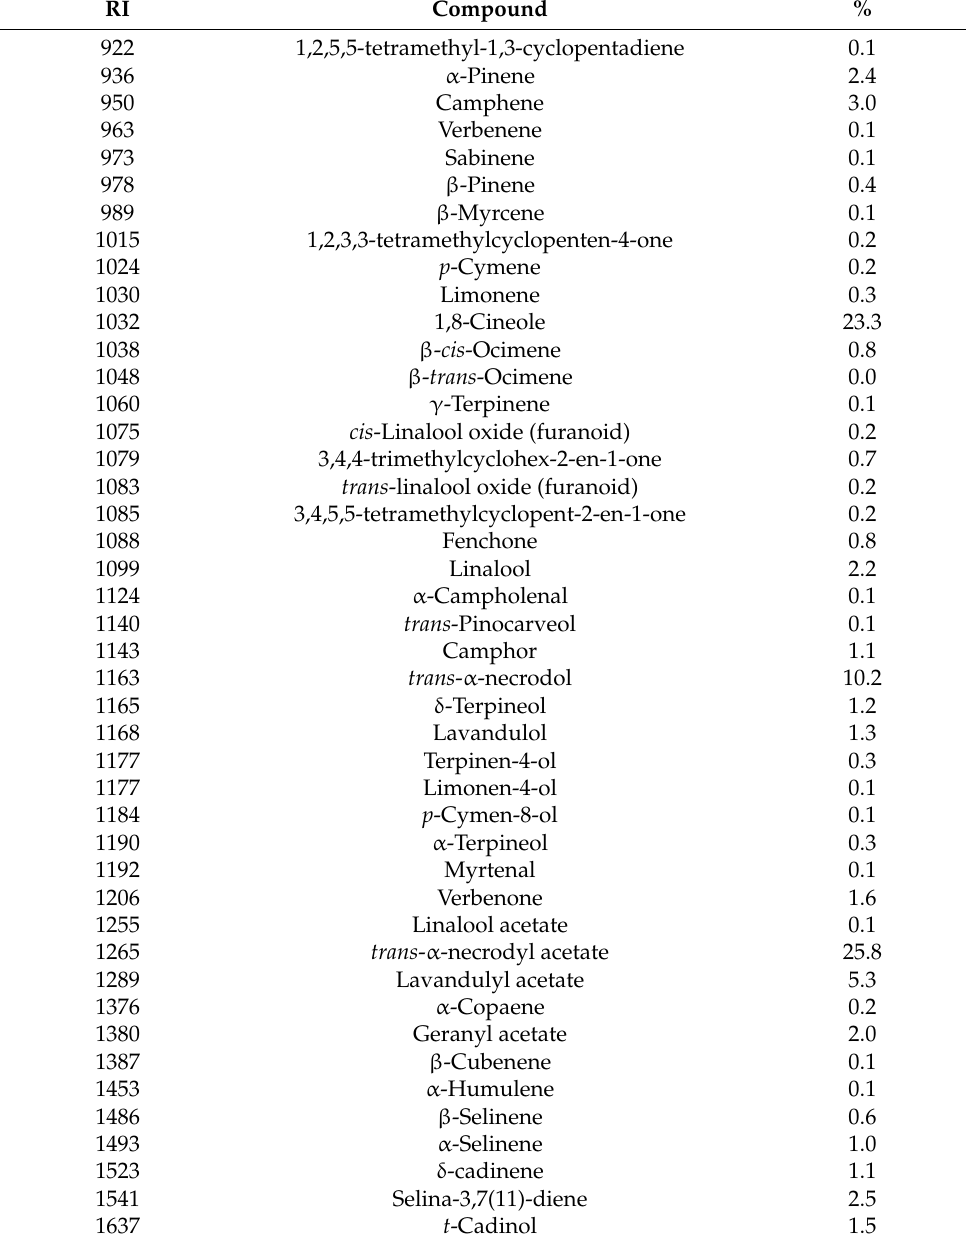
Table 1. Chemical composition of Lavandula luisieri